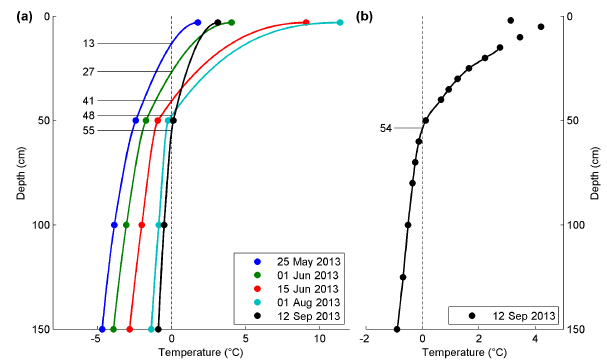
Figure 2. Temperature depth profiles from site KC1. (a) tempera- ture depth profiles using only four depths for selected days with the estimated thaw depth to the left. (b) temperature depth profile with all 16 temperature measurements for the date near maximum thaw